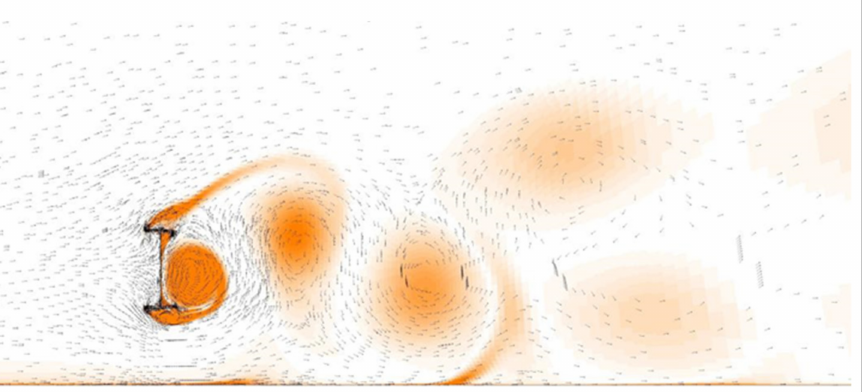
Figure 6. Vorticity contour for a particular moment of the simulation with h = 3 m, b = 0.9 m, z 0 = 3 m, and U = 5 m/s (double column, B&W in the printed